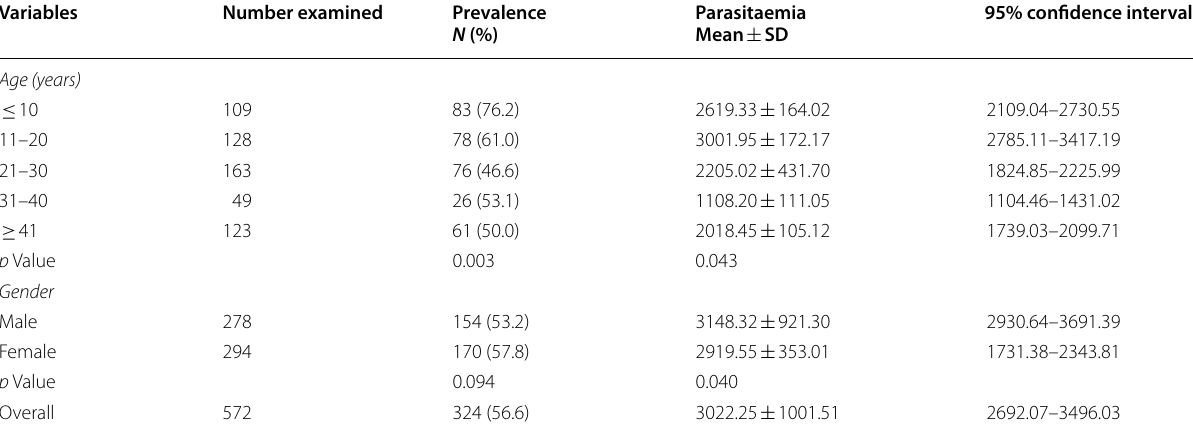
Table 1 Malaria prevalence and intensity stratified by age and sex